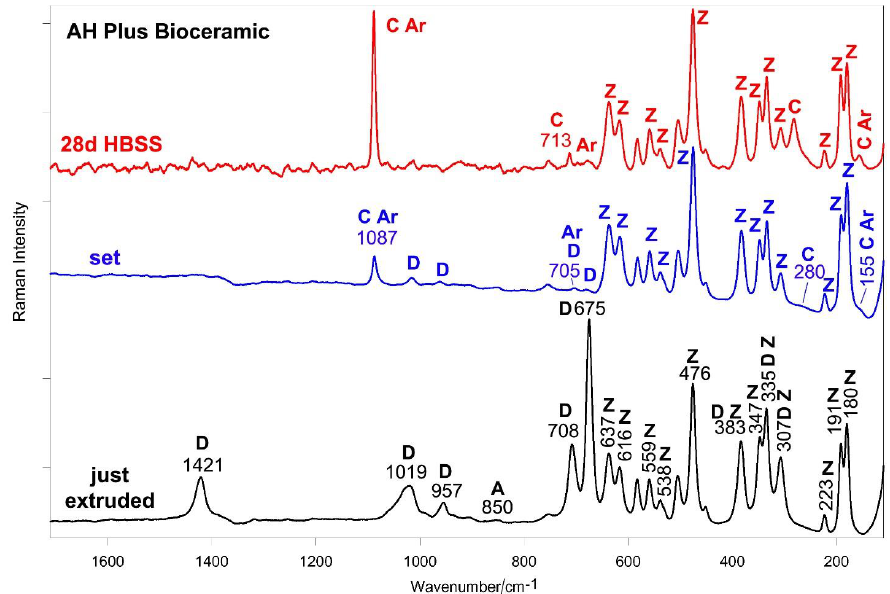
Figure 9. Average micro-Raman spectra recorded on just extruded AH Plus Bioceramic (black) as well as on the surface of set disks before (blue) and after aging in HBSS for 28 days (red). The bands assignable to dimethyl sulfoxide (D), tricalcium silicate (alite) (A), monoclinic zirconia (Z), calcite (C) and aragonite (Ar) are indicated. The micro-Raman spectrum of just extruded AH Plus Bioceramic (Figure 9) shows the bands of dimethyl sulfoxide [48,49] and monoclinic zirconia [27,32]. Tricalcium silicate was revealed through the broad band at about 850 cm −1 [30,31,45]. No lithium carbonate [43] was detected. In the Raman spectrum of the set sample (Figure 9), the bands of DMSO decreased in intensity, but did not disappear; the IR spectrum has to be interpreted accordingly (Figure 8). Therefore, the IR bands at about 1030 and 950 cm −1 have a contribution from DMSO, although they underwent a significant broadening upon sealer setting. Moreover, they may be assigned to the silicate component. Actually, the band at 950 cm −1 may be ascribed to the formation of the CSH phase [36,39] together with the component at about 1030 cm −1 as well as the shift and broadening of the band at 480 cm −1 due to the contribution of its Si-O-Si bending (reported at about 500 cm −1 ) [39]. Both IR and Raman spectra (Figures 8 and 9) revealed that carbonation of the sealer occurred, with formation of calcite and aragonite polymorphs of calcium car- bonate [29,35 – 37,40]. IR spectra (Figure 8) revealed that upon aging in HBSS the prevailing phase is calcite, with low amounts of aragonite; as expected, the most stable polymorph (i.e. calcite) be- comes prevalent upon aging for 28 days and evidently aragonite transformed into calcite [40]. By normalizing the spectra to the intensity of the zirconia band at about 735 cm −1 , only a slight strengthening in the 1030 cm −1 spectral profile (where PO 43 − stretching of cal- cium phosphates is reported to fall) was observed, whilst no significant increases in the 560 – 600 cm −1 bands (where PO 43- bending modes fall) were detected. These trends indi- cated minor amounts of calcium phosphate phases. The IR band at 950 cm −1 shifted to 970